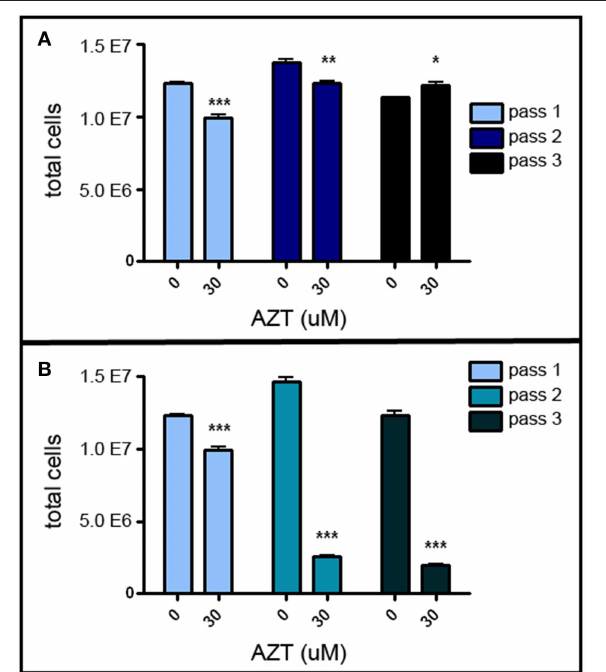
FIGURE 1 | AZT reduces MASC population expansion. (A) Primary MASCs exposed to a single 7 day pulse of 30 µ M AZT show a significant decrease in population expansion over the first and second passages (1stP, 2ndP). By the third passage (3rdP), treated cells recover and slightly exceed the expansion of untreated cells, although this difference was not maintained, and control and treated groups equilibrated at later passages (not shown). (B) Naïve 1stP, 2ndP, and 3rdP MASCs exposed to a single 7 day pulse of 30 µ M AZT show that “older” cells (increased in vitro passage) are substantially more vulnerable to the suppressive effects of AZT than “younger” cells. Unpaired t -test of significance; N = 3 for all groups; ∗ p < 0 . 05 ; ∗∗ p < 0 . 01 ; ∗∗∗ p < 0 . 001 . Error bars represent standard